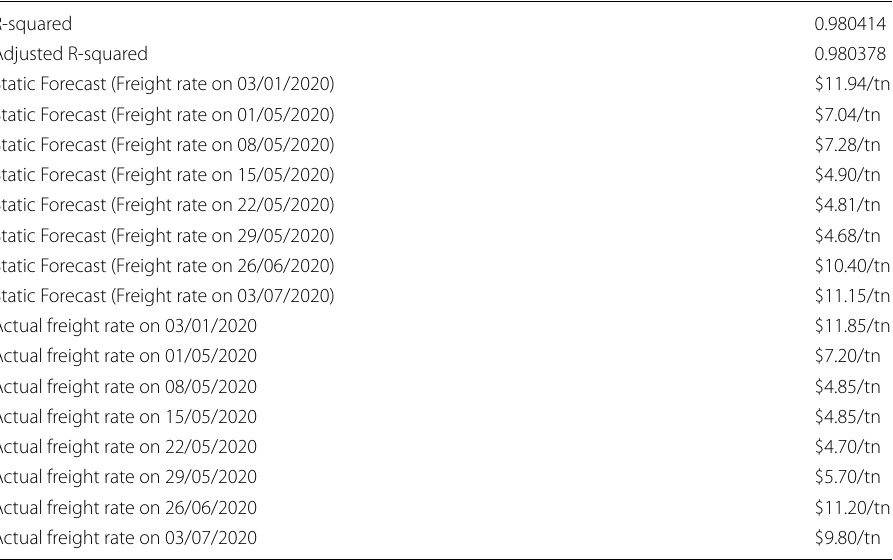
Table 2 Baltimore–ARA coal. Source : Elaboration by the authors R-squared 0.980414 Adjusted R-squared 0.980378 Static Forecast (Freight rate on 03/01/2020)